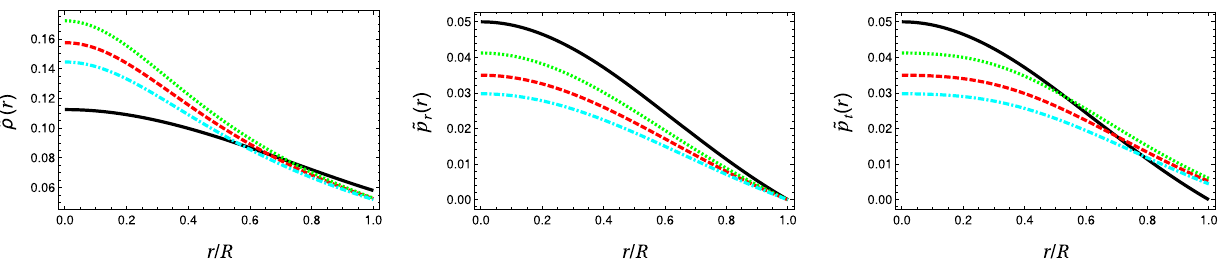
tion is minimally deformed by a ψ –sector. Two different solutions are presented: dotted green line for { α = 0 . 3 ,β = 0 . 03 } and the dotted- dashed cyan line for { α = 0 . 3 ,β = − 0 . 03